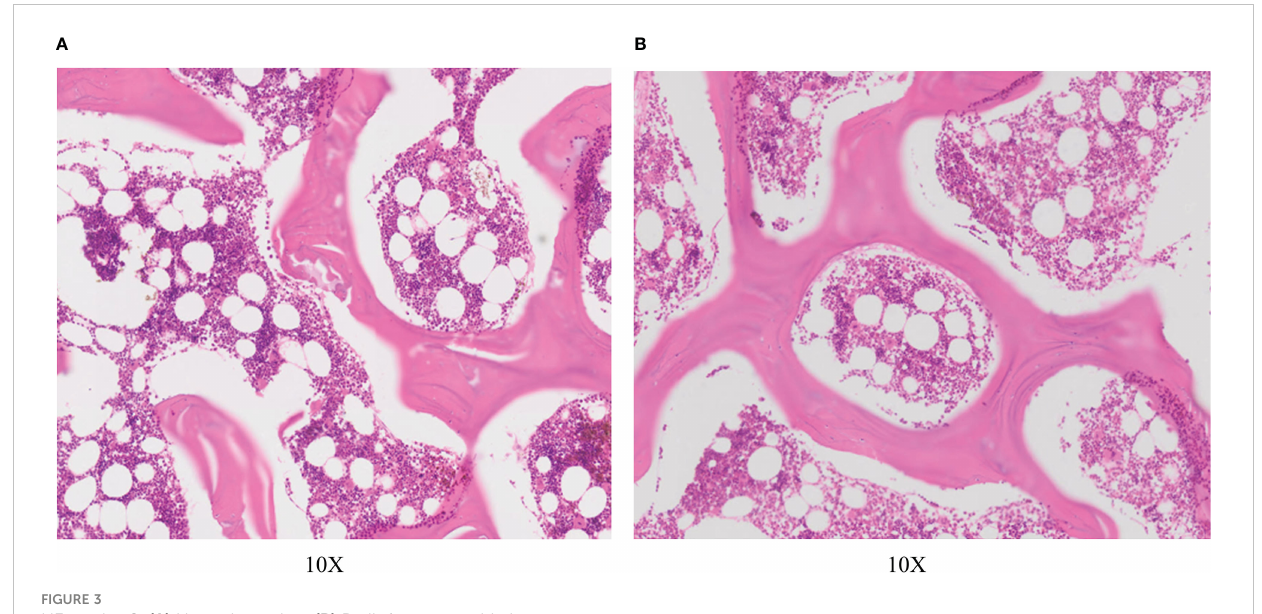
FIGURE 3 HE on day 0. (A) Normal vertebra. (B) Radiofrequency ablation